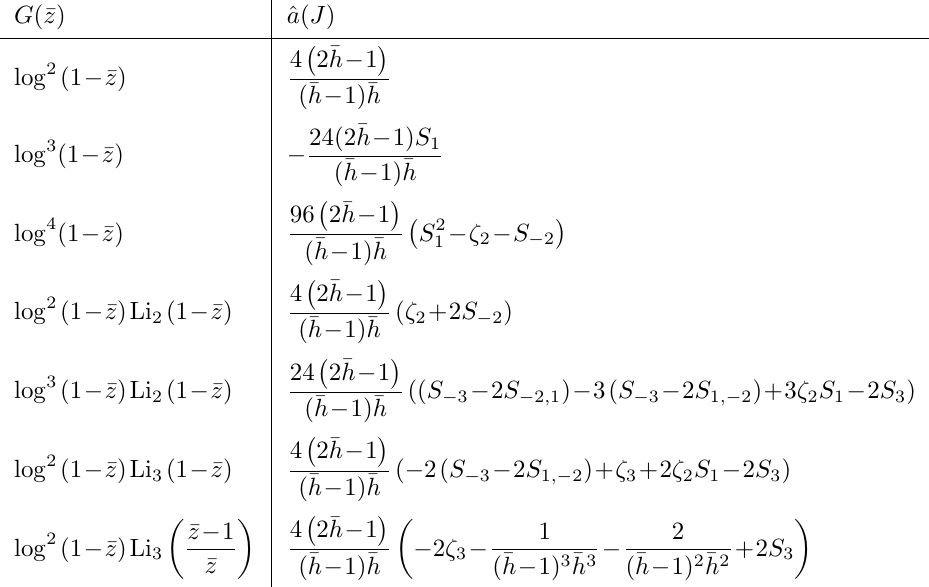
Table 1 . Inversions for G ((cid:22) z ) not containing explicit powers of log (cid:22) z .